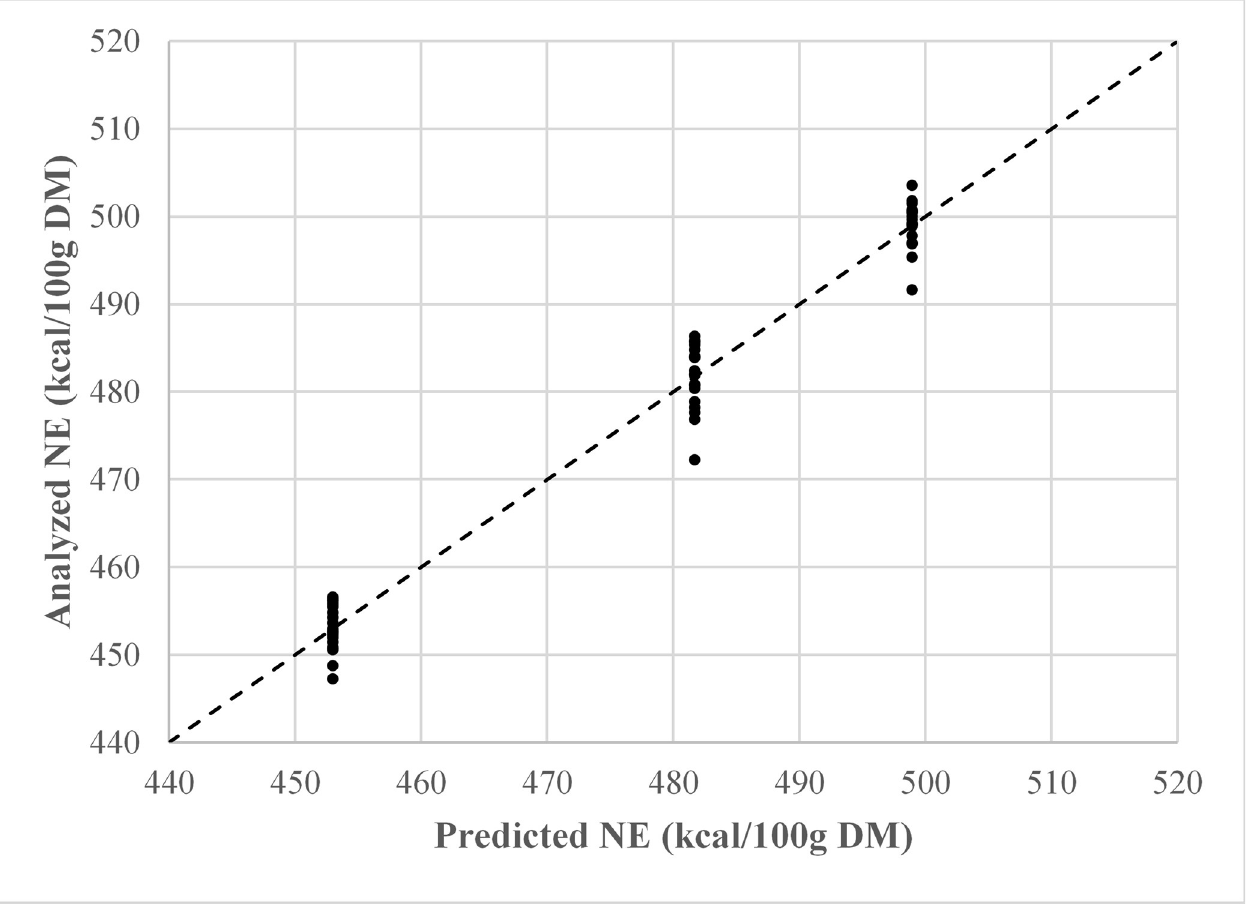
Fig 2. Observed versus predicted plot of dietary net energy using equation 1 (NE = (.946 × ME) + (.519 × CP)– 2.186); R 2 = .976.